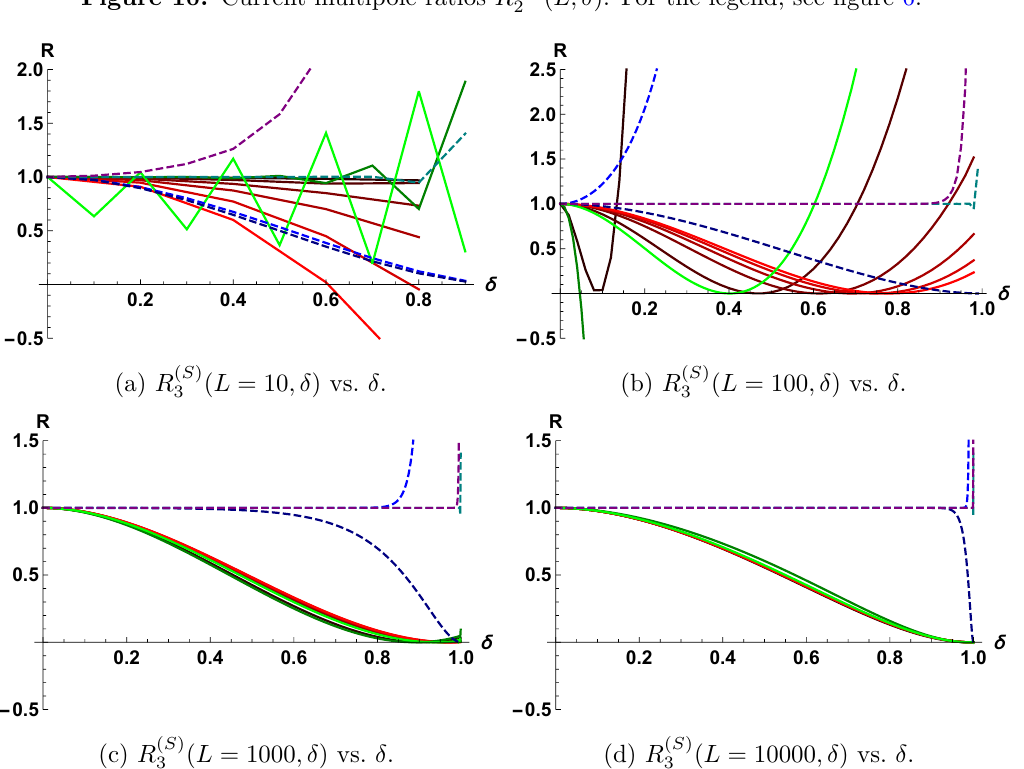
Figure 10. Current multipole ratios R ( S )